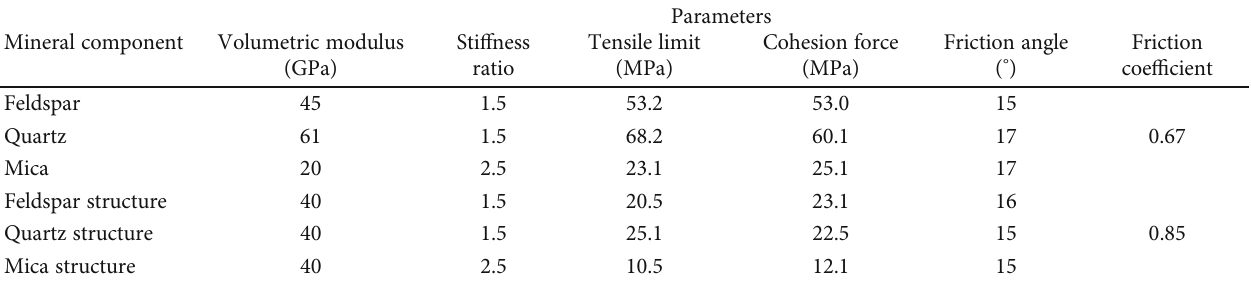
Table 3: Mesoscopic parameters of di ff erent component contact